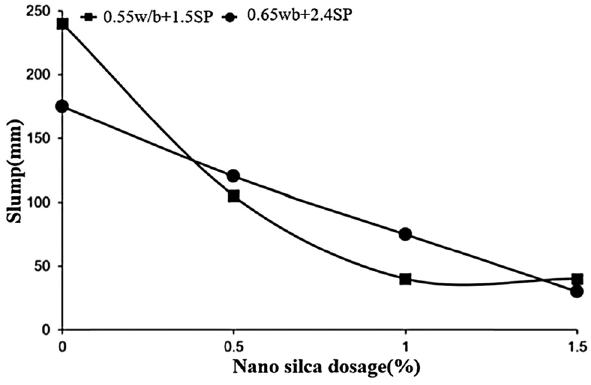
Figure 4: Relationship between NS content and slump [ 57 ]